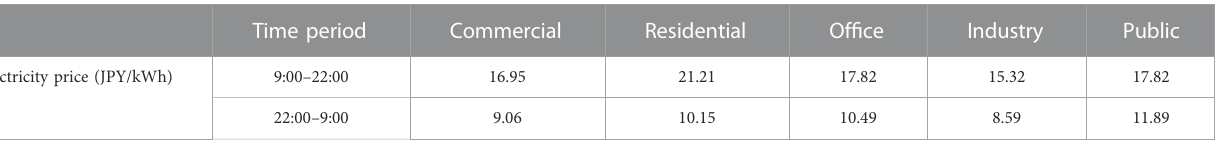
TABLE 4 Electricity price model of different types of buildings.